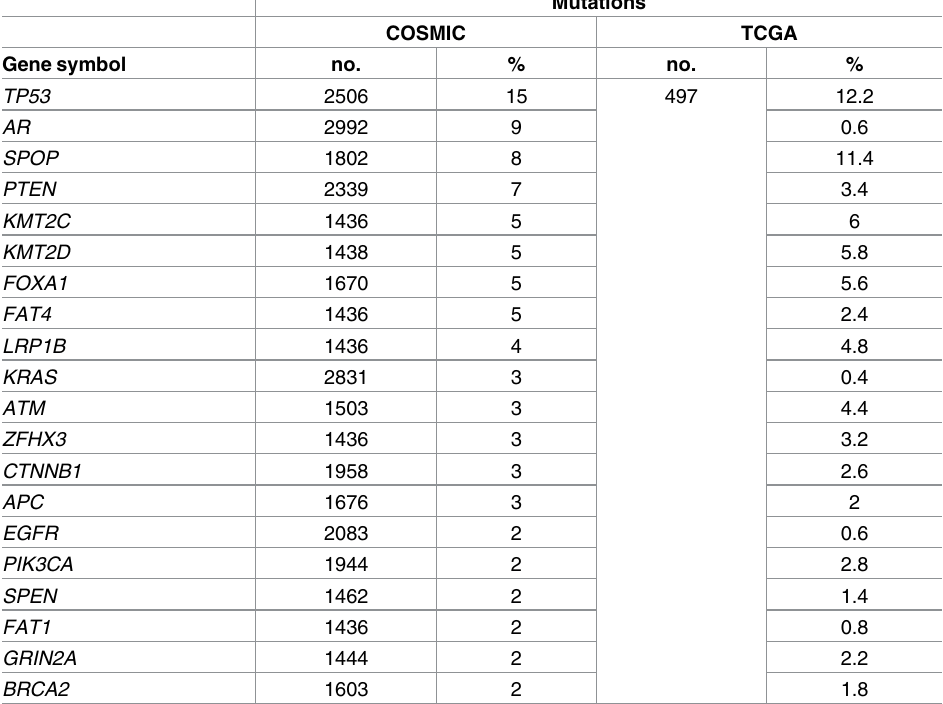
Table 3. Top 20 mutations reported by COSMIC database vs PRAD cohort.